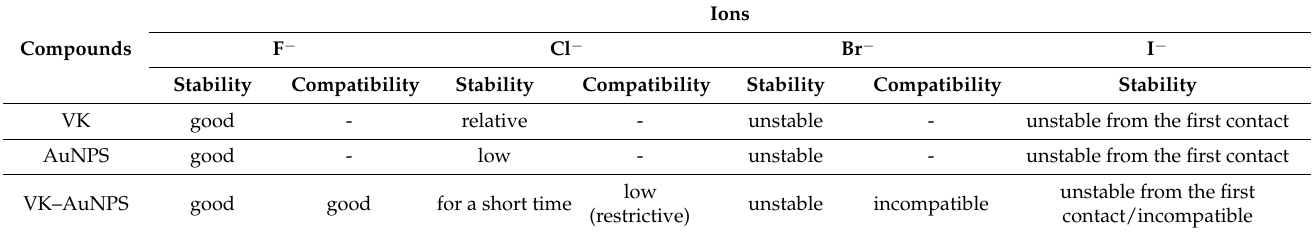
Table 2. Systematization of the results obtained from electrochemical measurements regarding the chemical stability and incompatibility of vitamin K (VK) and gold nanoparticles (AuNPs) in sodium halide solutions.